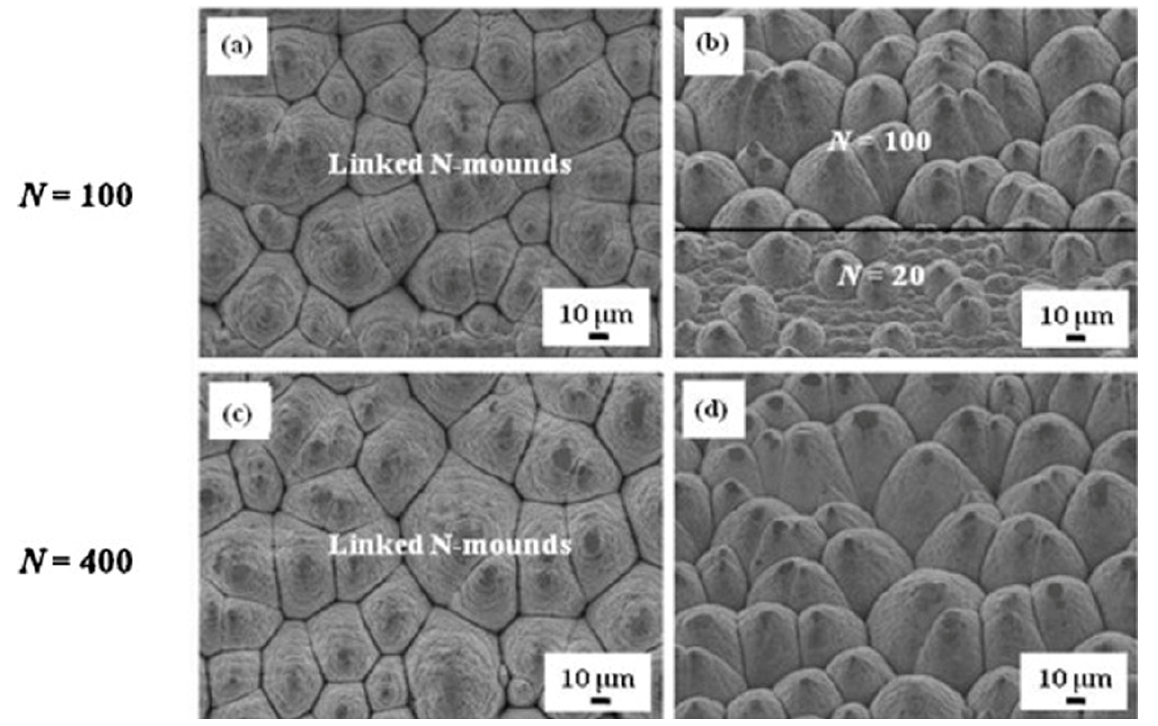
Figure 8. Linked N -mound microstructure. ( a , c ) were normal to the surface; ( b , d ) were taken at a 40 ◦